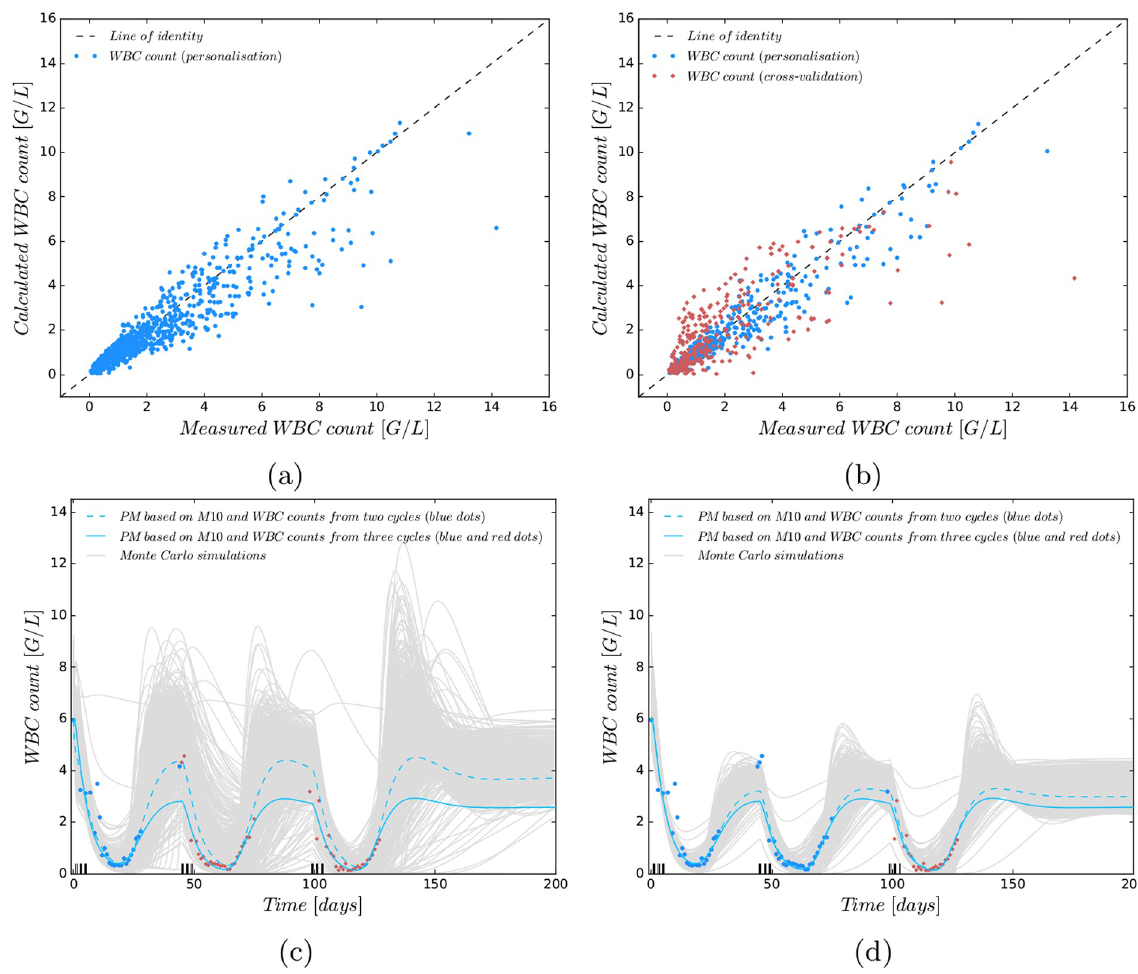
Fig 3. Visualisation of predictive accuracies of personalised mathematical models (PM). ( a ) Goodness-of-fit plot for M10. Shown are measured versus calculated white blood cell (WBC) counts. Models were personalised using complete data sets of one to three cycles from 23 patients. The measured counts around the nadir coincide well (RMSE = 0.740) with the calculated WBC counts. ( b ) As (a), but cross-validated: WBC counts from the last cycle of patients were not used for personalisation, but compared to predictions (RMSE = 0.927). The plot shows cross-validated WBC counts from the last cycle in red, others in blue. The plots are prototypical for M1–M12. ( c ) PMs based on M10 and either personalisation with WBC counts from one or from all three cycles. 1000 Monte Carlo simulations after personalisation with WBC counts from one cycle were used to indicate the propagated probability density function. ( d ) As (c), but using WBC counts from the first two cycles for personalisation. More measurements lead to higher prediction accuracy. The uncertainty tube tightens and the predicted trajectory gets closer to the solution that used all available WBC